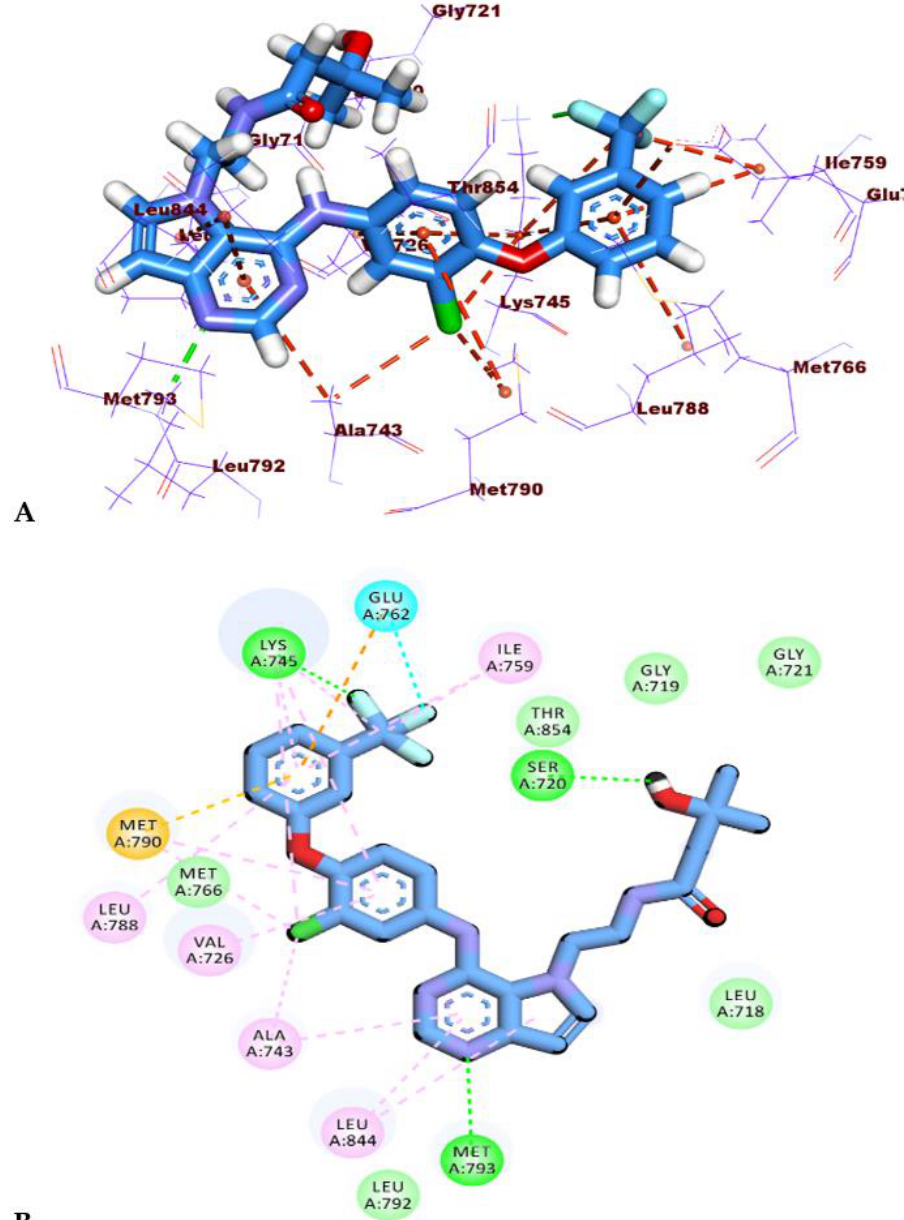
Figure 5. ( A ) 3D and ( B ) 2D interaction pattern of TAK-285 in EGFR T790M active site. The designed compound, T-2-PNPA , was stacked onto the EGFR T790M catalytic site similarly to the native ligand, as shown in Figure 6. In the adenine pocket, the 3,7-dimethyl-2,6-dioxo-2,3,6,7-tetrahydro-1 H -purine moiety achieved eight HIs with Leu844, Leu718, Ala743, and Met793 as well as two HBs with Thr845 and Met793. Moreover, two electrostatic interactions were observed in the hydrophobic pocket via the interaction of p -nitrophenyl moiety with Lys745 and Glu762.